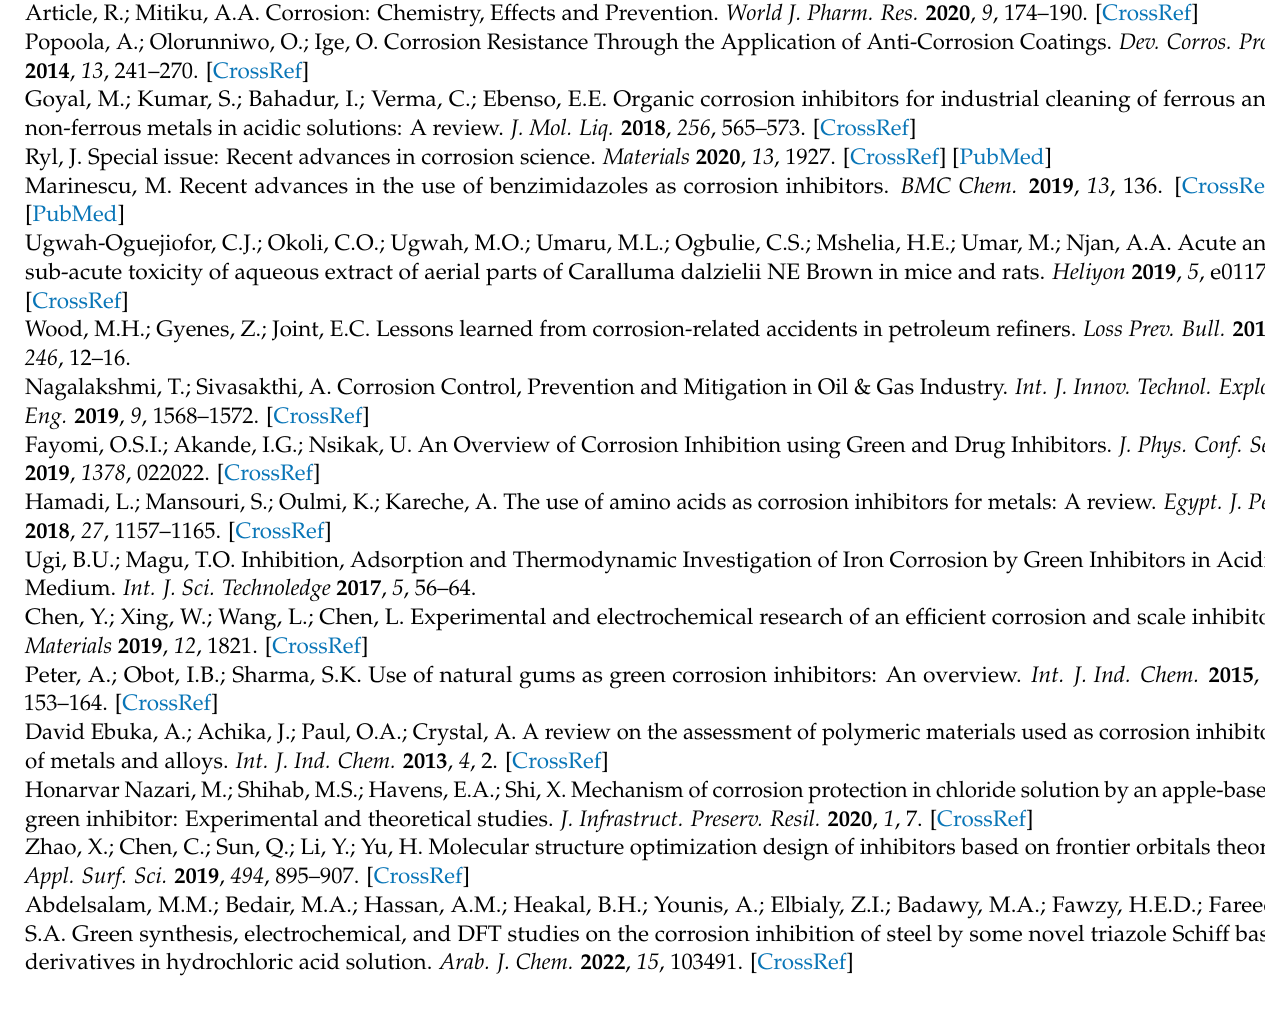
Table S3. Percentage change of E HOMO values in the HCl environment. Table S4. Percentage change of E LUMO values in the HCl environment. Table S5. Percentage change of ∆ E values in the HCl environment. Table S6. Percentage change of ∆ N values in three different corrosion environments. Table S7. Percentage change of ∆Ψ values in three different corrosion